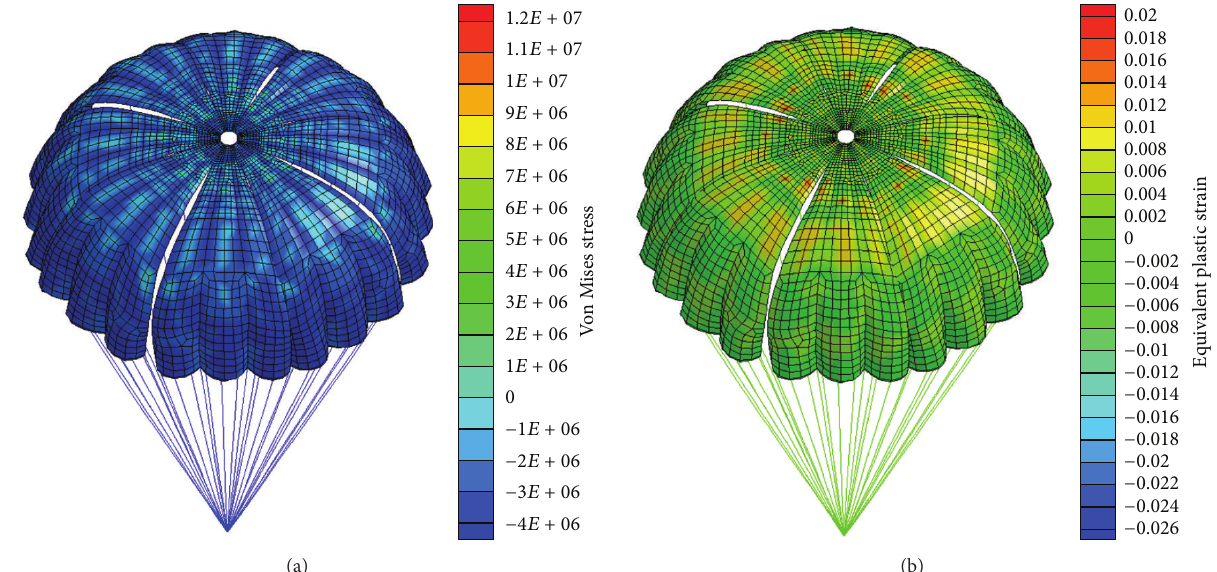
Figure 10: Von Mises stress and equivalent plastic strain distributions during opening ((a) is Von Mises stress results and (b) is equivalent plastic strain